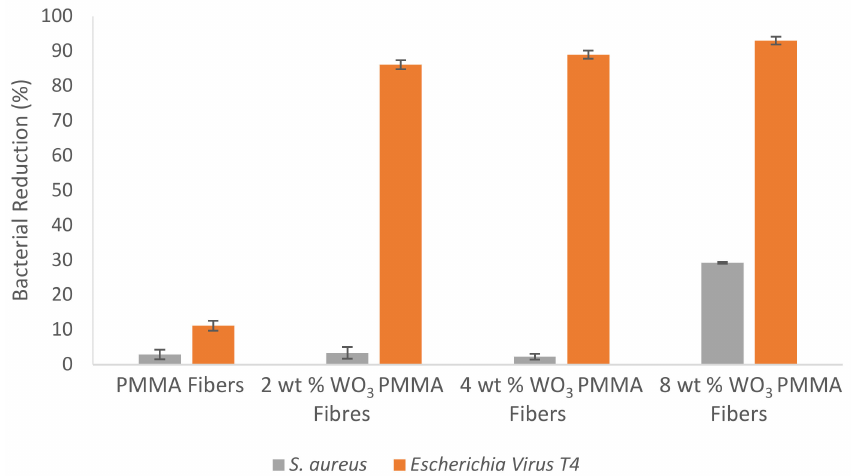
Figure 6. Graph showing the antimicrobial activity of tungsten oxide / polymer nanocomposite fibres against S. aureus and bacteriophage T4. Error bars represent standard deviation, n = 3. 2 wt % and 4 wt % tungsten oxide loaded fibres also showed no antibacterial activity with 96.6% and 97.7% of the bacterial population remaining alive, respectively. The 8 wt %